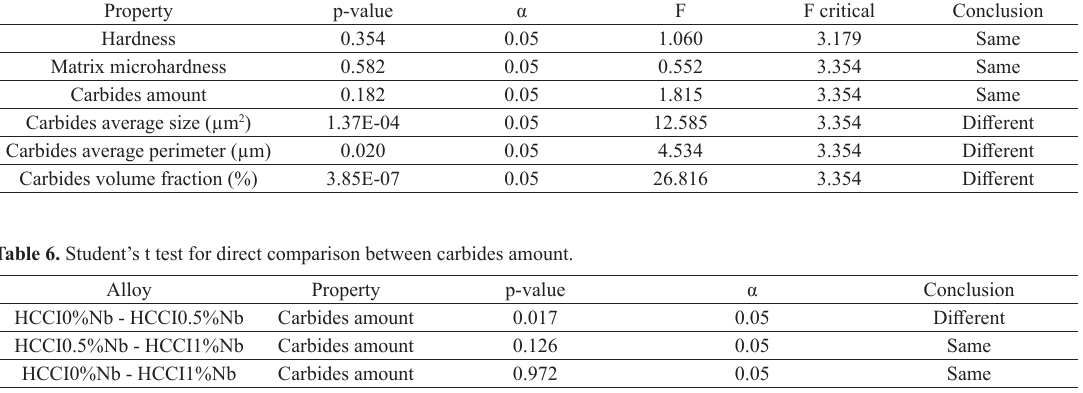
Table 5. ANOVA variance analysis of the alloys microstructural properties and quantifications. Property